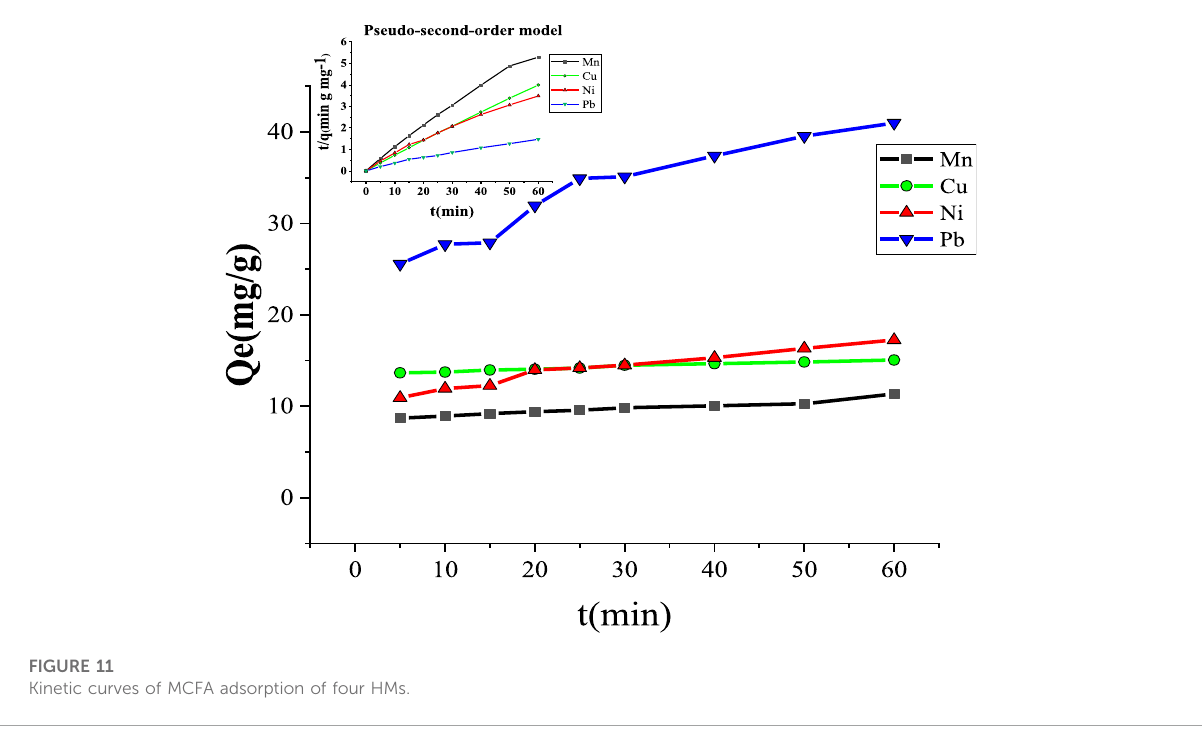
FIGURE 11 Kinetic curves of MCFA adsorption of four HMs.